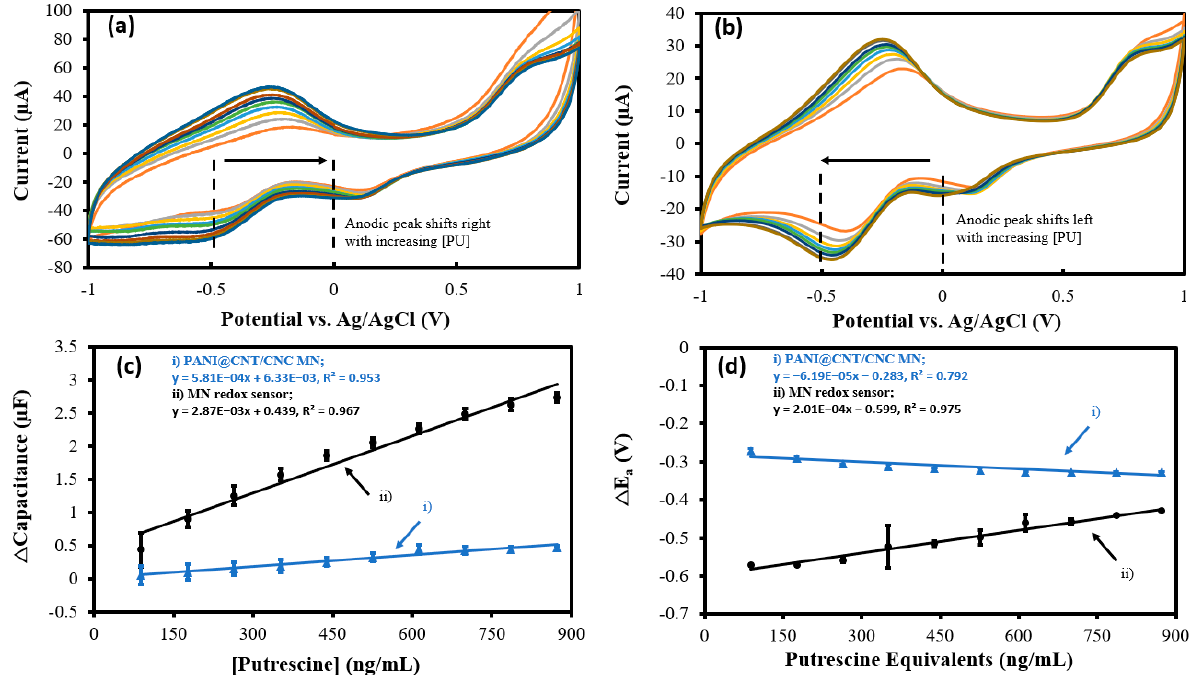
Figure 7. Representative CVs showing ( a ) MN redox sensor; and ( b ) PANI@CNT/CNC microneedle (MN) electrochemical response to 88.0–873 ng/mL putrescine and resulting ( c ) cathodic Δ capacitance; and ( d ) Δ E a vs. putrescine concentration calibration plots obtained using the ( i ) PANI@CNT/CNC microneedle (MN) and ( ii ) MN redox sensor. Table 1. Capacitive and ORP sensitivities for the PANI@CNT/CNC microneedle (MN) and MN re- dox sensor in response to ascorbic acid, H 2 O 2 , and putrescine analytes.